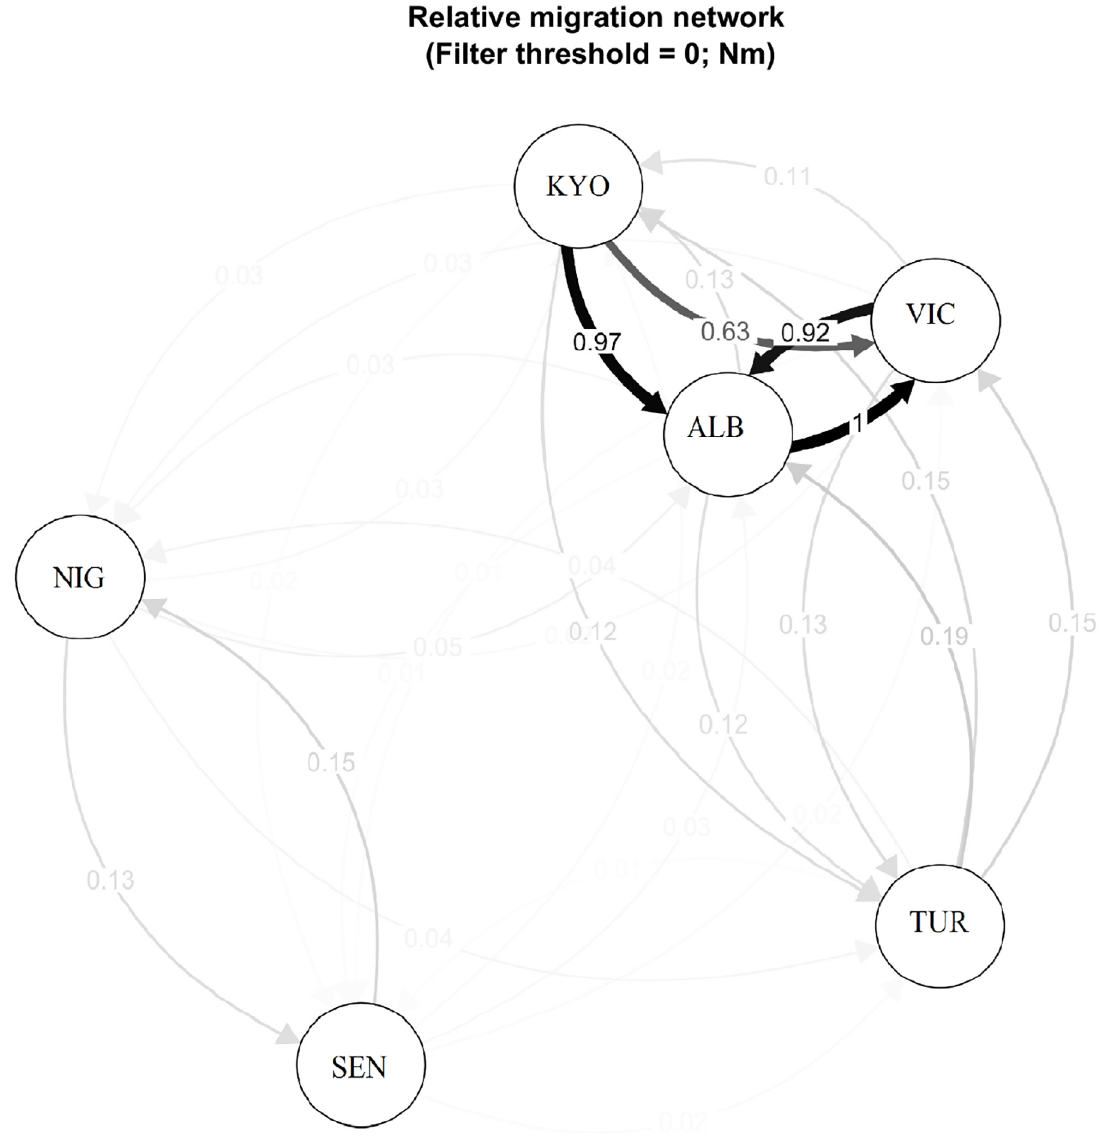
Fig 4. Relative migration network diagram for Nile perch, Lates niloticus from six sample locations in West and East Africa. Circles represent sample locations;—SEN- Senegal, NIG -Nigeria, ALB—Albert, KYO—Kyoga, VIC -Victoria and TUR -Turkana. The arrows contain edge values showing the direction and magnitude of migration levels, with the darker arrows showing stronger gene flow. The figure reveals stronger gene flow between populations ALB- Albert (putative population) and VIC- Lake Victoria (translocated population originally from mainly Lake Albert) albeit reduced gene flow between Lake Albert and Lake Kyoga (another translocated population also from Lake Albert).